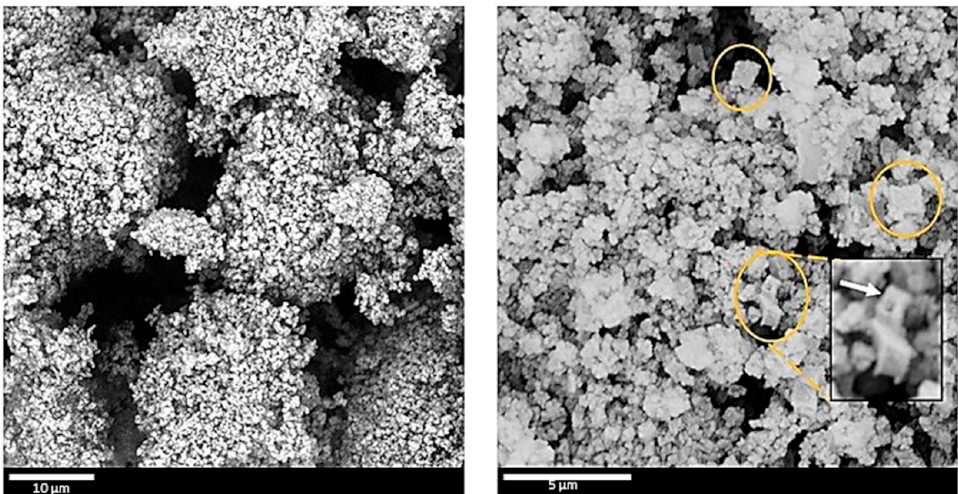
Figure 8. SEM images of the sample C-MOF/EB-1-a at magnifications 5000 × ( left ) and 15,000 × ( right ). Examples of cubical particles are circled; on the inset, a cubical particle with a cavity is marked by an arrow.